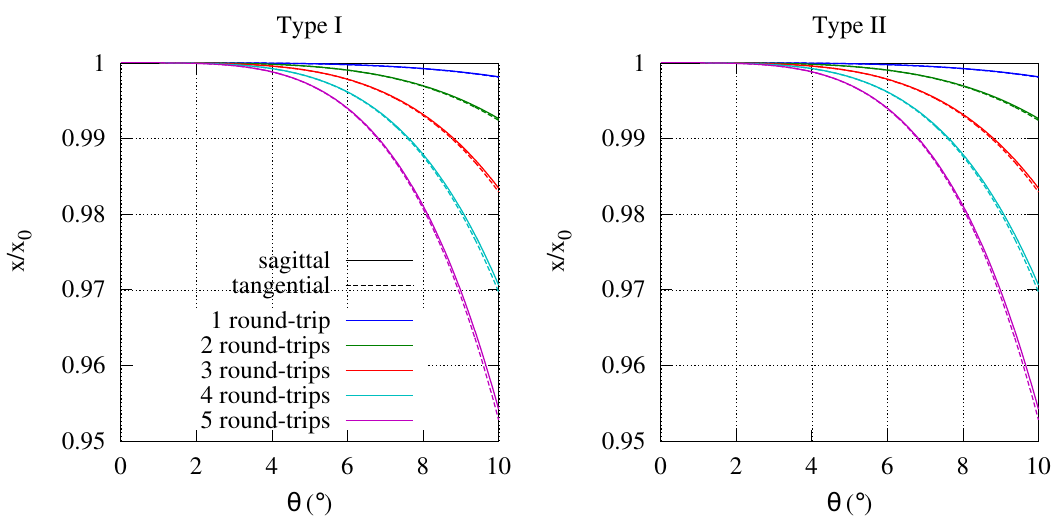
Figure 5. Change in beam diameter in the tangential and sagittal plane as a function of the folding angle θ for Type I and Type II systems for up to five round-trips.